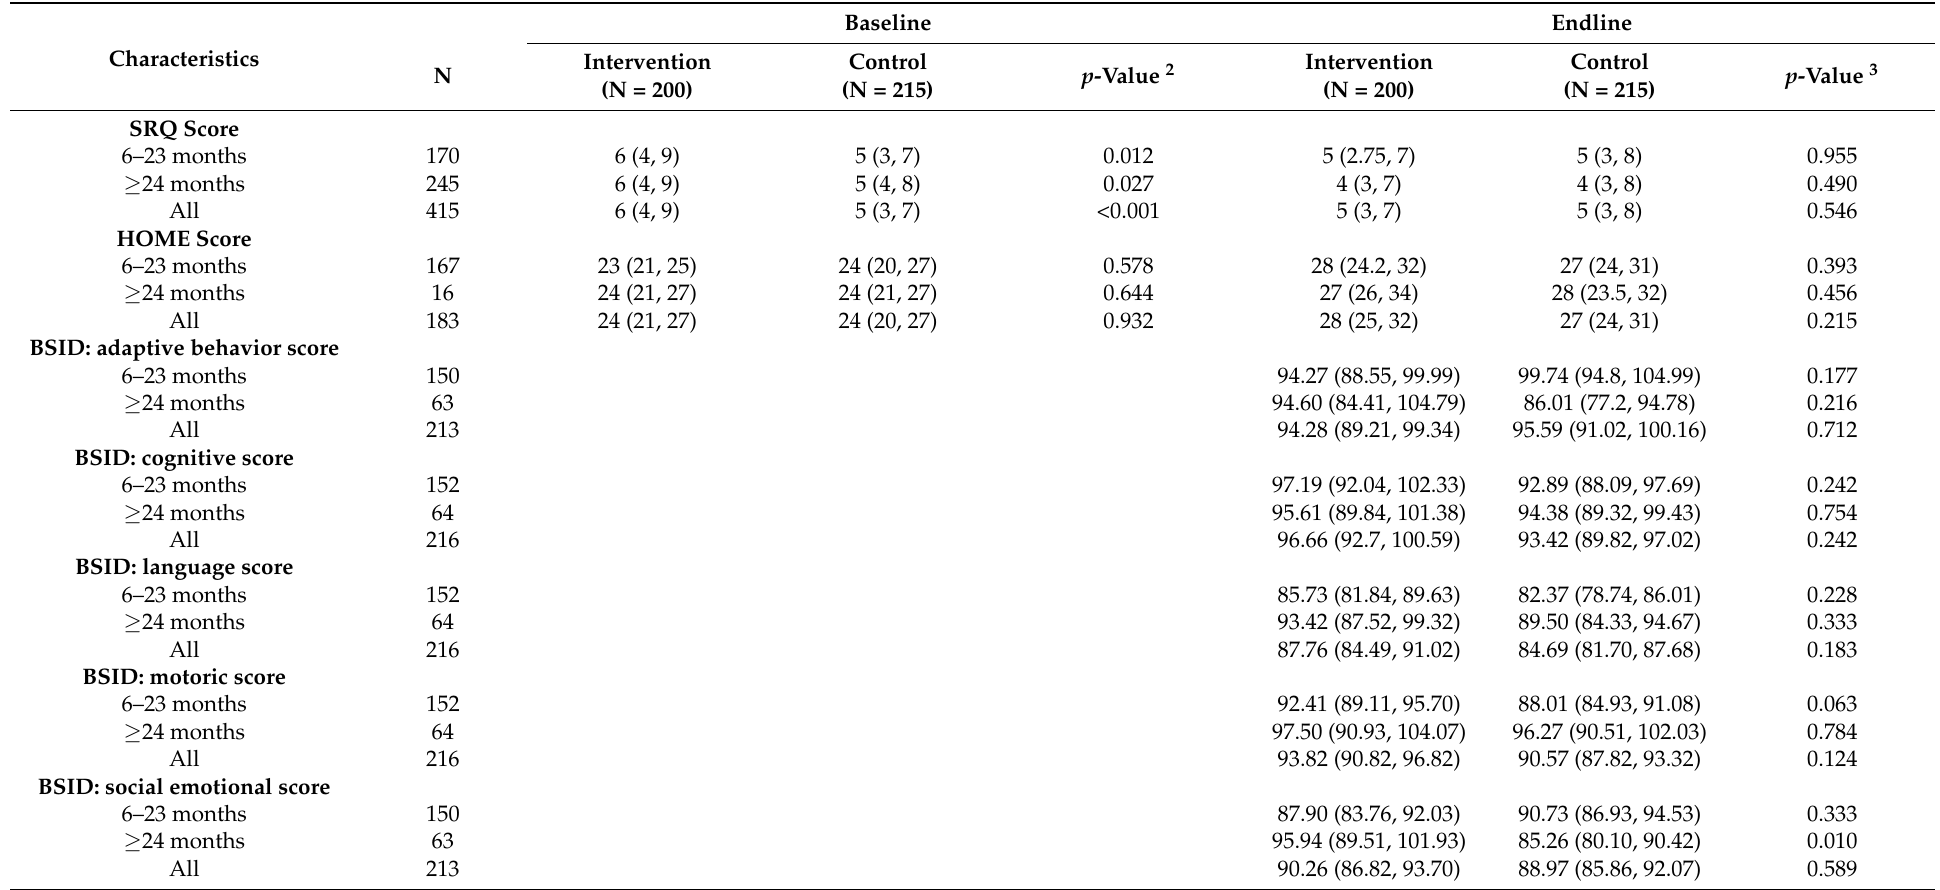
Table 5. Maternal stress (SRQ), psychosocial care (HOME) and developmental outcomes (BSID) at baseline and end line, by age and treatment groups 1 .